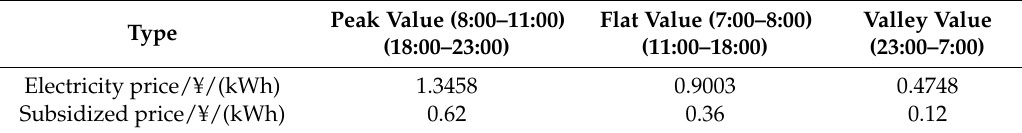
Table 7. Time-of-use electricity prices.